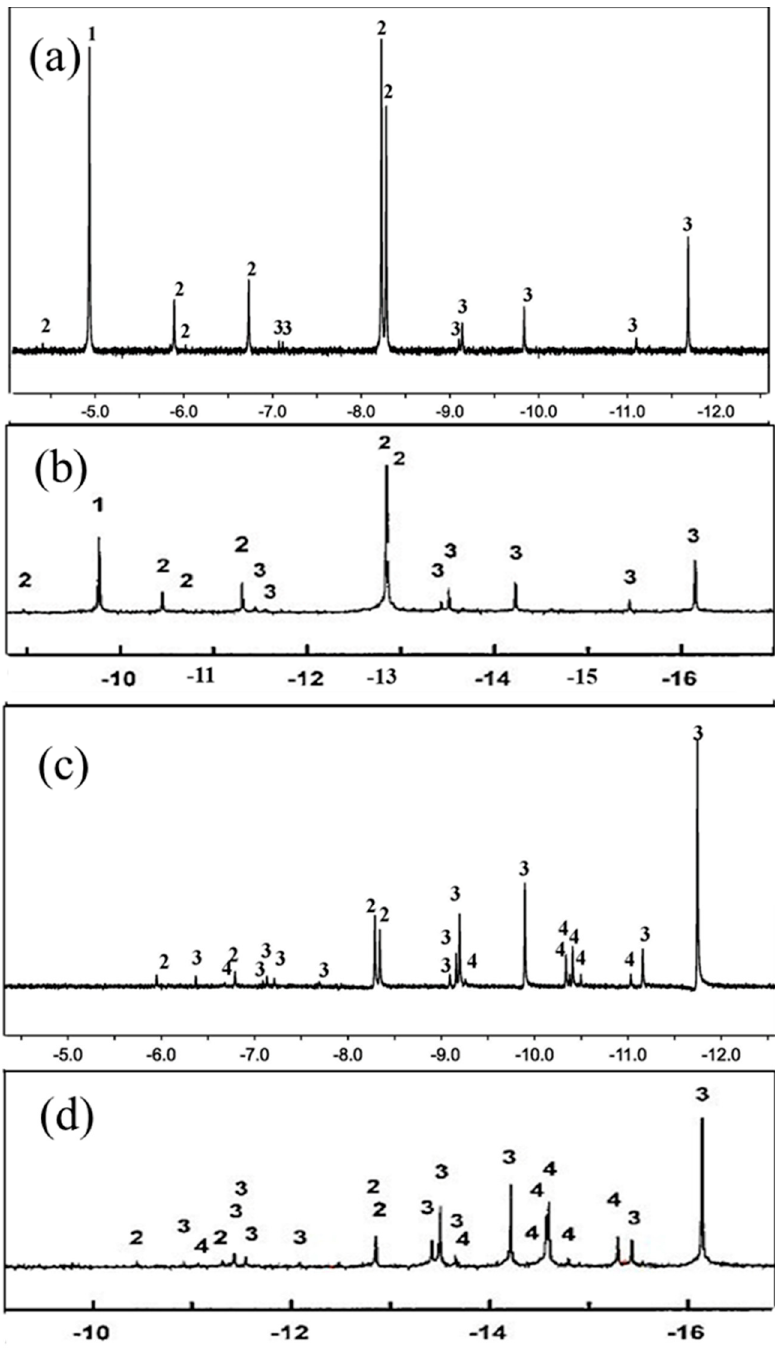
Figure 3. ( a ) 1 H NMR spectra of H 2 @C 60 with 2.5 equiv of DMA, ( b ) 3 He NMR spectra of 3 He@C 60 with 2.5 equiv DMA; ( c ) 1 H NMR spectra of H 2 @C 60 with 10 equiv of DMA; ( d ) 3 He NMR spectra of 3